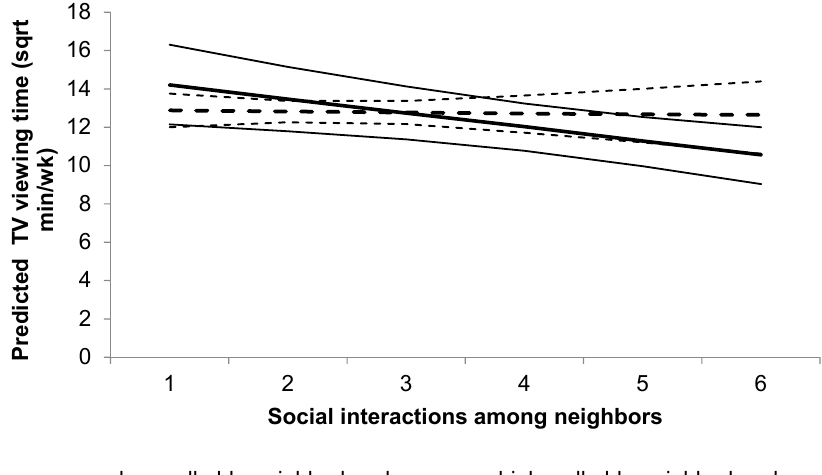
Figure 2. Interaction between social interactions among neighbors and neighborhood walkability for the predicted TV viewing time. Plot represents TV viewing levels (square root transformed variable) for high-walkability (thicker full line) and low-walkability (thicker dashed line) neighborhood residents, and their confidence intervals (thinner lines).